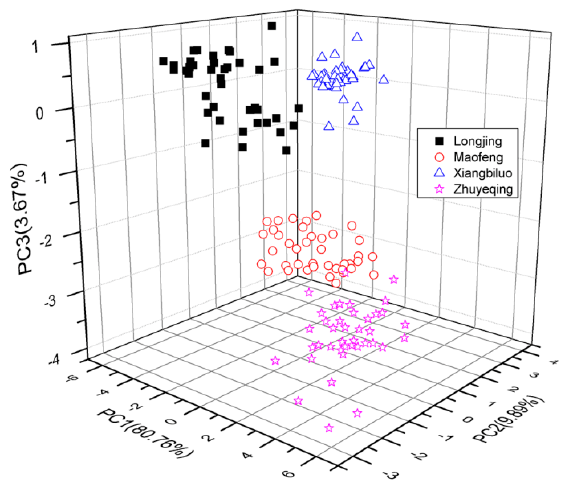
Figure 6. Scattered scores plot PC1, PC2, and PC3.